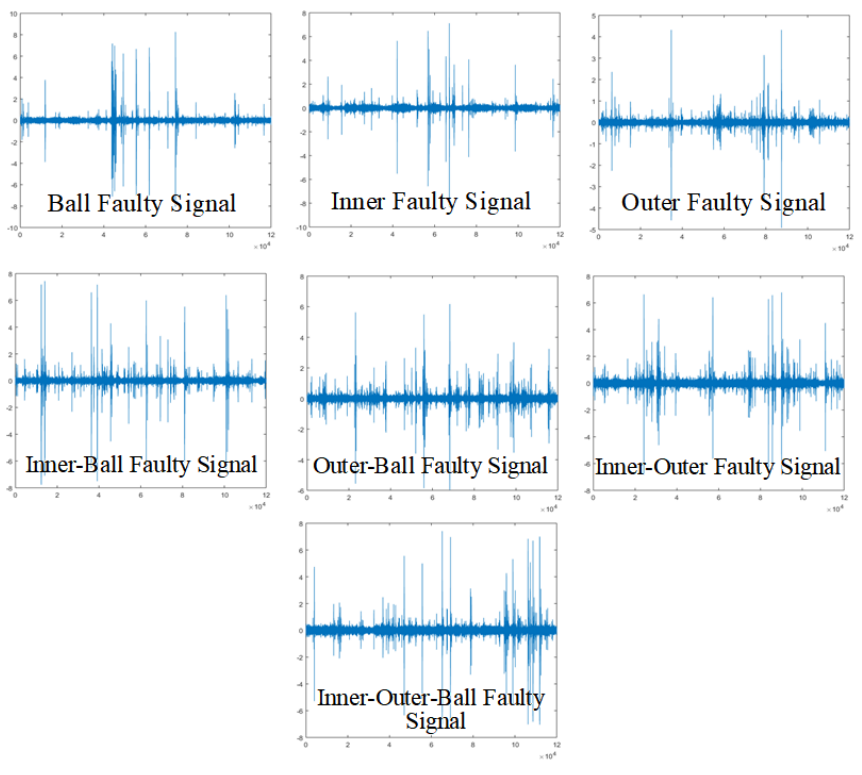
Figure 10. Original raw signals for various faulty conditions.